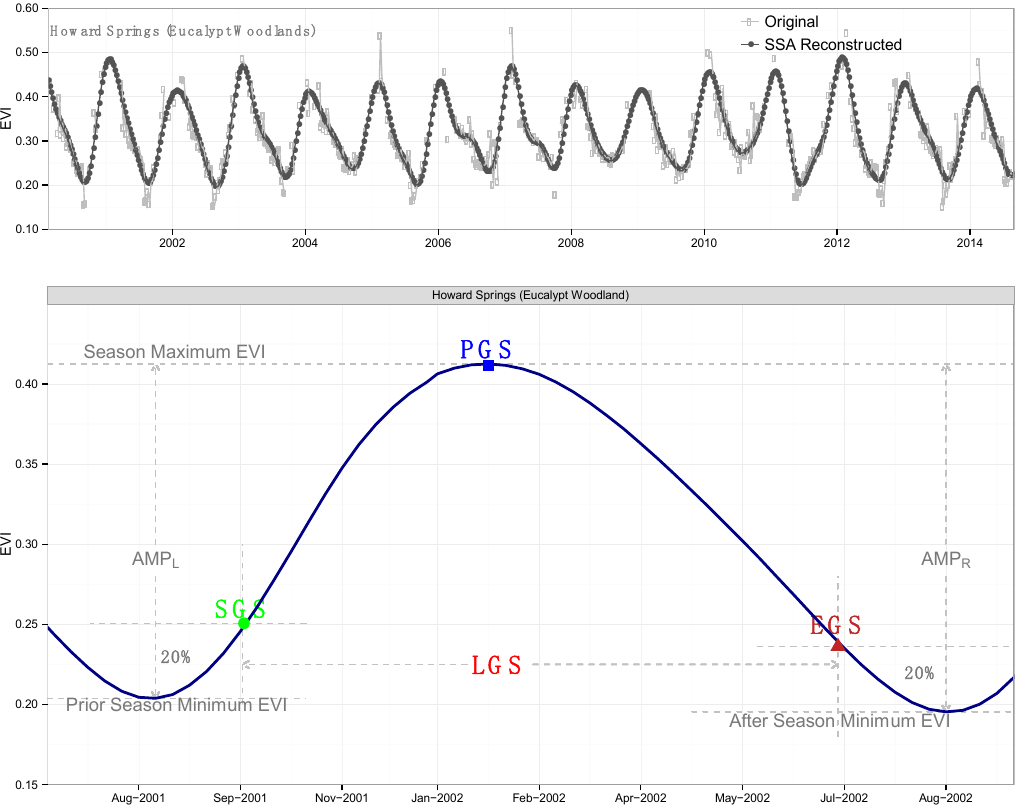
Figure 2. Diagram of the Singular Spectrum Analysis (SSA)-Pheno algorithm for deriving phenological metrics. The top panel shows the original MODIS VI time series and SSA-reconstructed VI time series for Howard Springs (Eucalypt woodland) from 2000 to 2014. The bottom panel shows the diagram for extracting phenological metrics using a VI profile of Howard Springs in 2001–2002. Phenological transition dates, including the start of growing season (SGS), the peak of growing season (PGS), the end of growing season (EGS), as well as the length of growing season (LGS) are labelled on the graph. SGS is defined as the timing when the enhanced vegetation index (EVI) passes the 20% threshold of the seasonal amplitude during the greenup phase (seasonal maximum EVI–prior season minimum EVI), and EGS is defined as the timing when EVI passes the 20% threshold of the seasonal amplitude during the browndown phase (seasonal maximum EVI–after season minimum EVI).